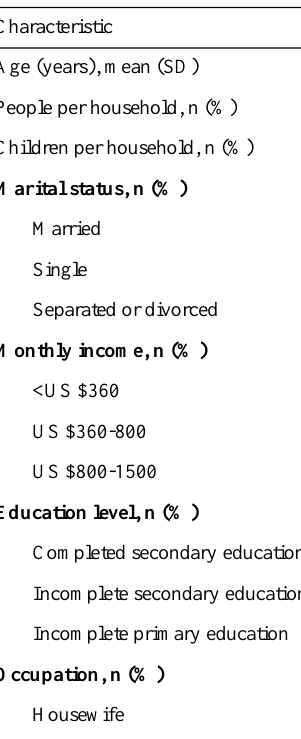
Table 1. Demographics of female focus group participants (N=27).